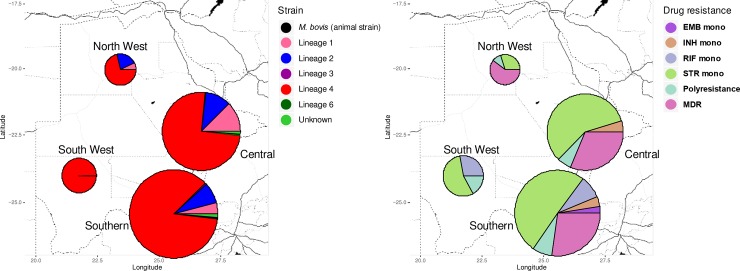
Geographical distribution of M.tb lineages and drug resistance profiles in Botswana.A map of Botswana is shown in which pie charts indicate (A) the M.tb lineages (see key). On the right map (B) the pie charts indicate the drug resistance profiles of the isolates (see key). The size of the pie chart is proportional to the number of isolates in the region.